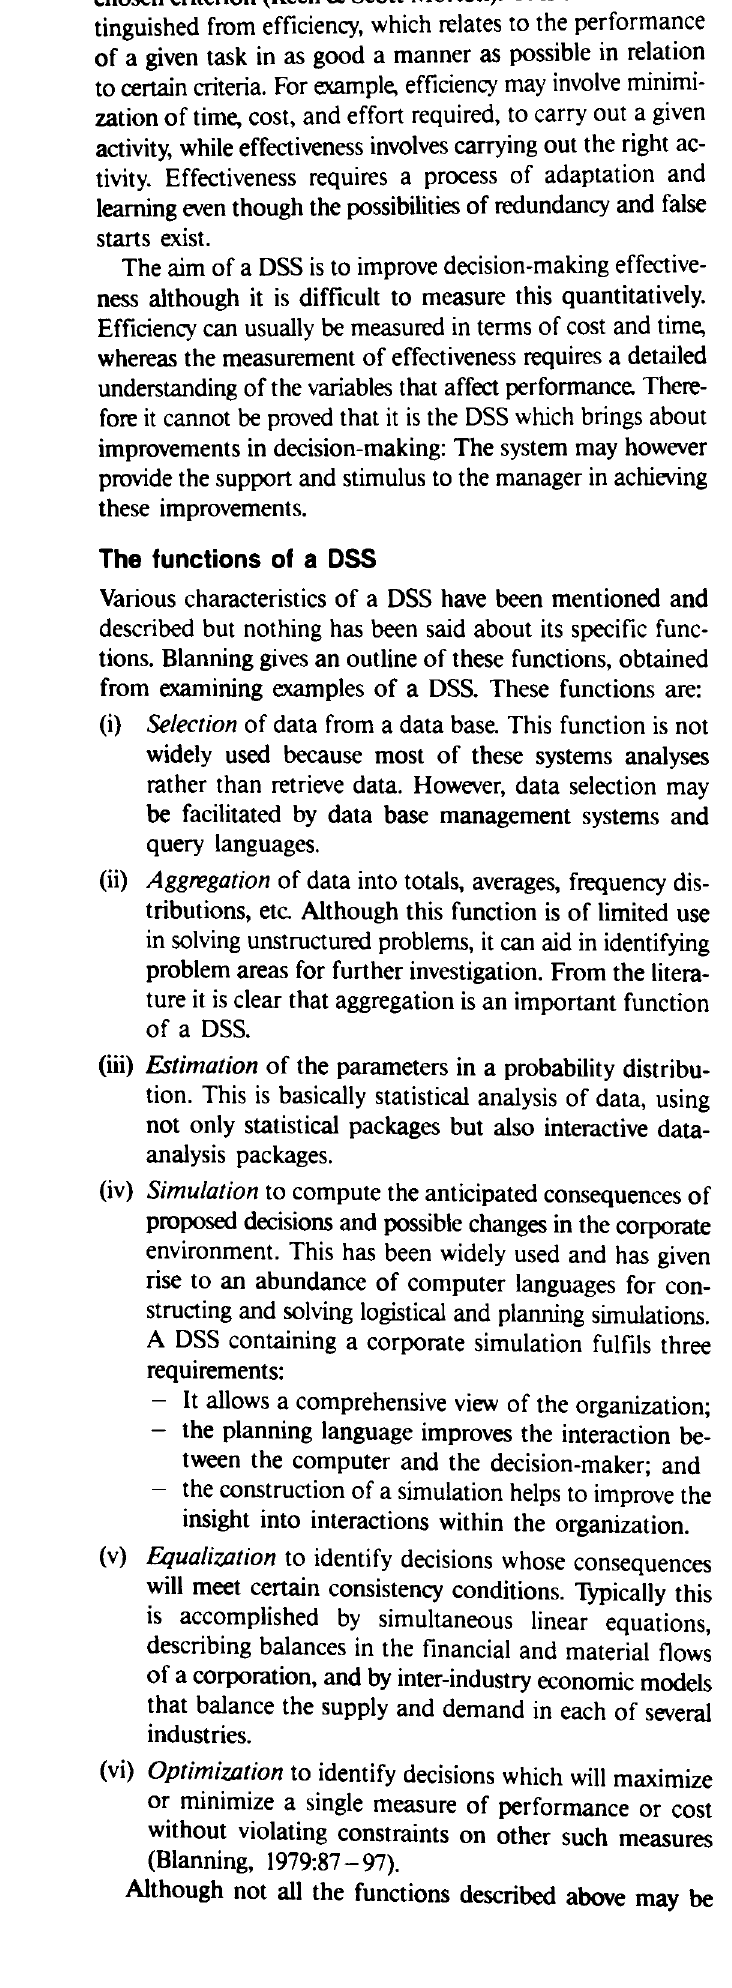
Figure 1 Three levels of a